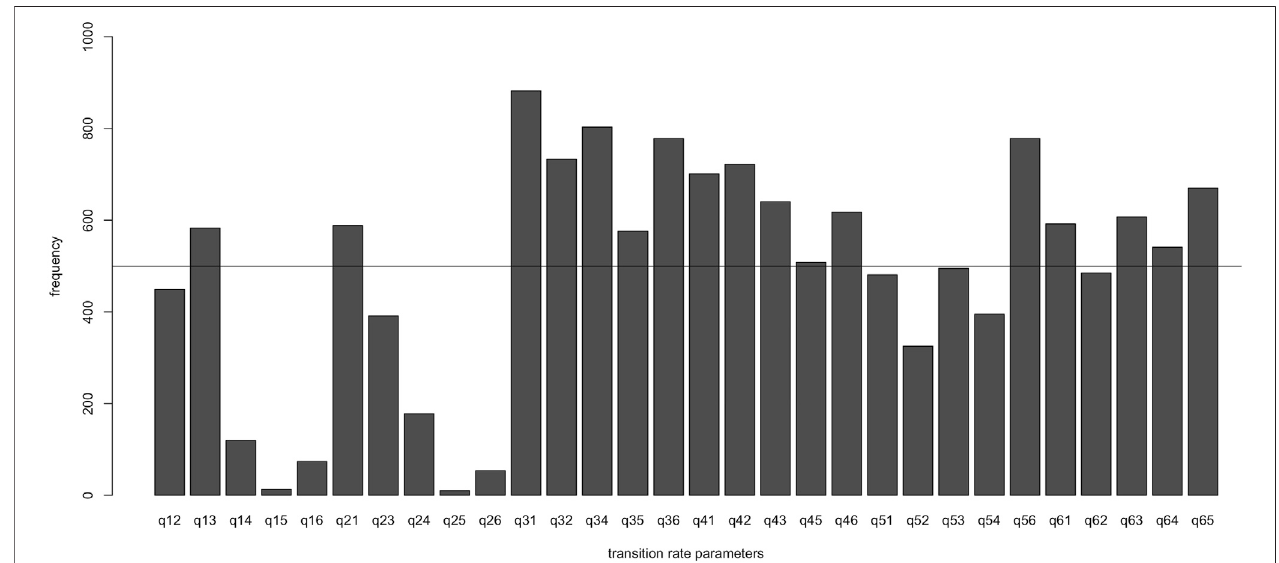
FIGURE 6 | Frequency of transition rate parameters being turned on in the RJ.FULL model. The y axis marks the number of posterior models in which a transition parameteristurnedon,withthehorizontallinemarkingbeingturnedonin50%oftheposterior.Type-Ahasbeencodedas1,ABas2,Bas3,BCas4,Cas5,andCAas 6. Hence, q12 refers to change A > AB; q13 refers to change A > B, etc. See Figure 1 for the Q